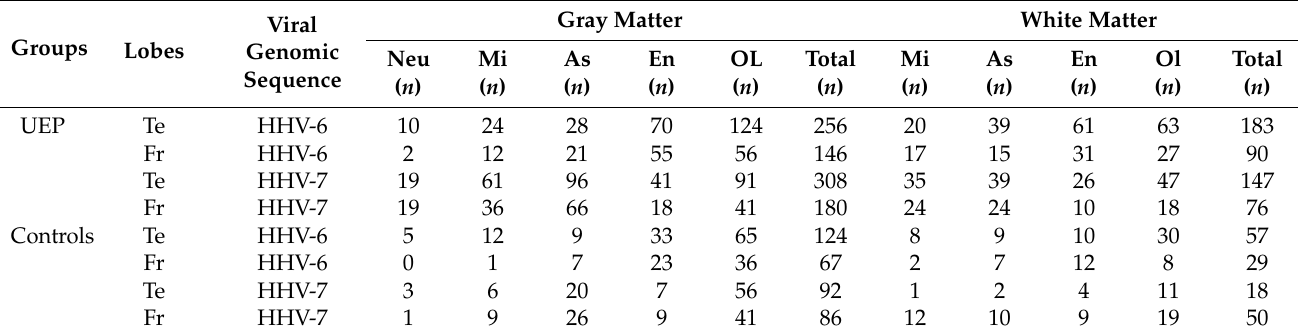
Table 3. Numbers of herpesvirus-6, -7 (HHV-6, -7) immunopositive cells in the PCR+ tissue samples of the frontal and temporal lobes in the UEP individuals and control group.